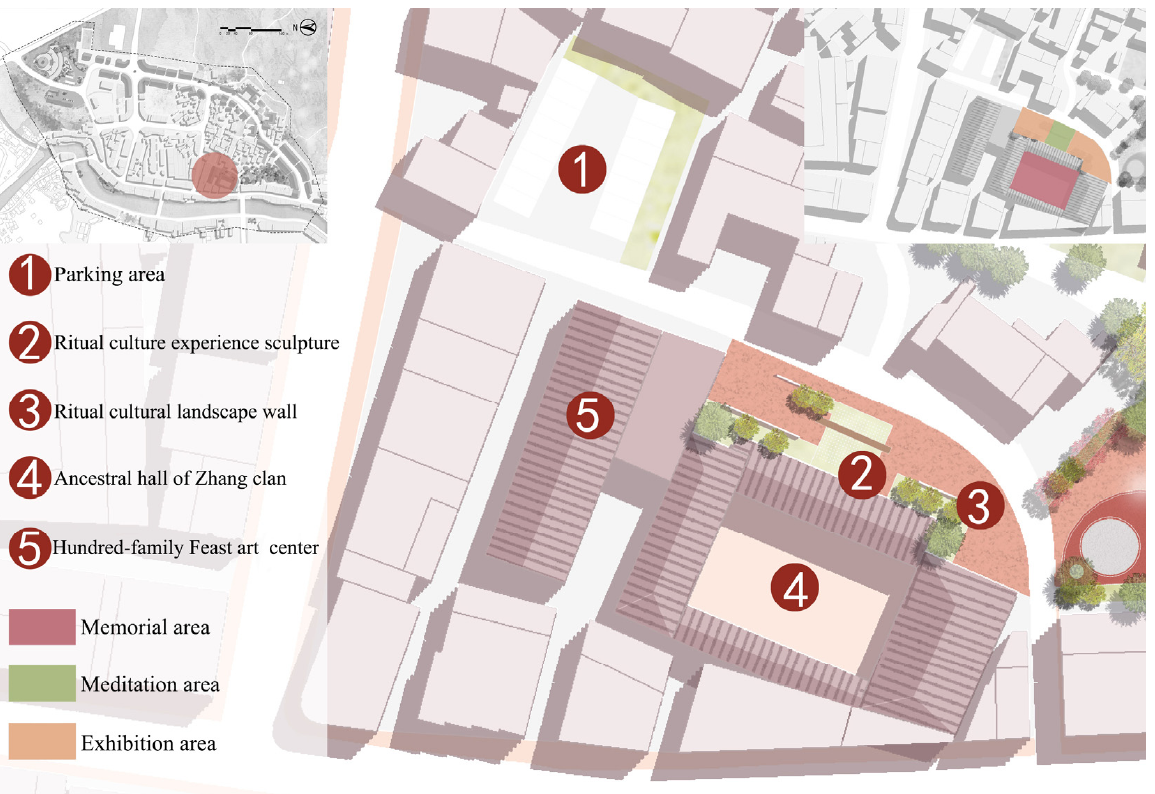
Figure 12. Plan of Ritual culture experience zone landscape.